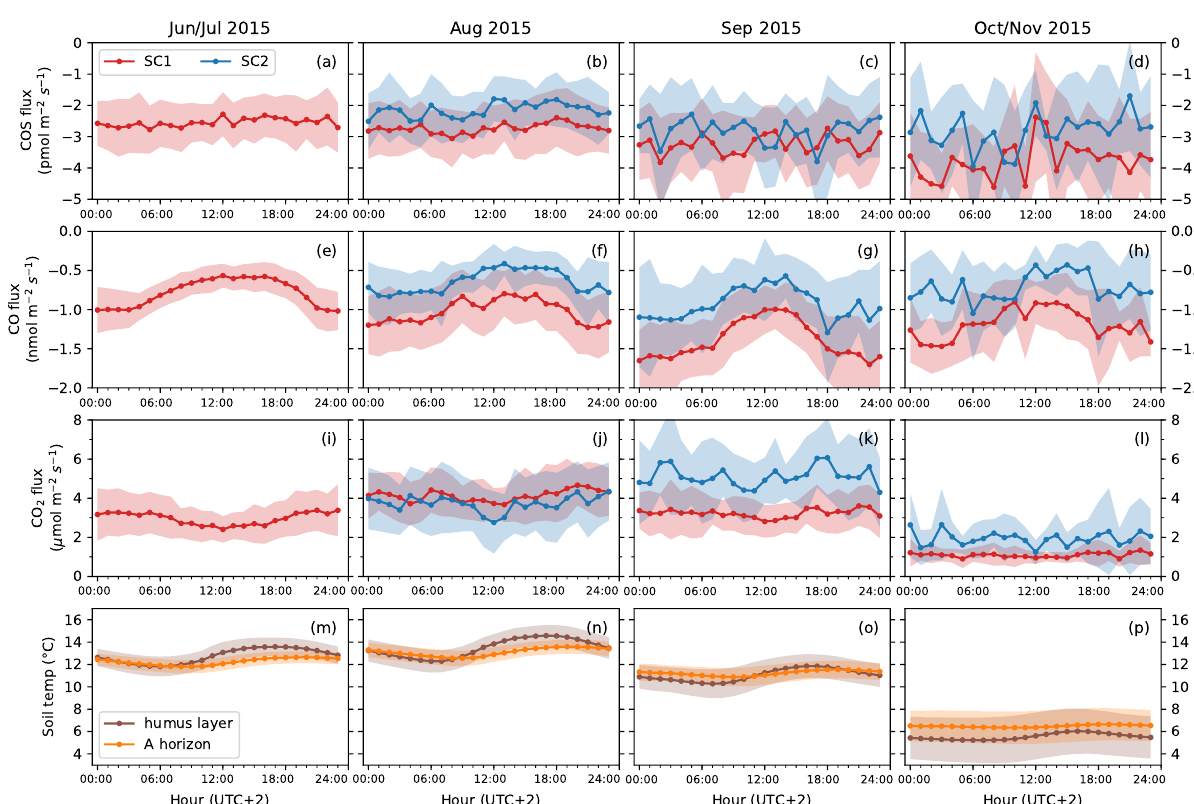
Figure 2. Monthly-mean diurnal trends of soil chamber fluxes of COS (a–d) , CO (e–h) , and CO 2 (i–l) , and temperature in the humus layer and in the A horizon (m–p) , averaged in 1h bins. The x axes are local time during winter (UTC + 2). Red and blue curves are mean diurnal trends of SC1 and SC2, respectively (a–l) . Brown and orange represent temperature in the humus layer and in the A horizon, respectively (m–p) . All shaded areas indicate ± 1SD. Note that for soil temperature the y axis ranges change by month. The July 2015 subset includes 2 days of data from June, and the October 2015 subset includes 2 days from